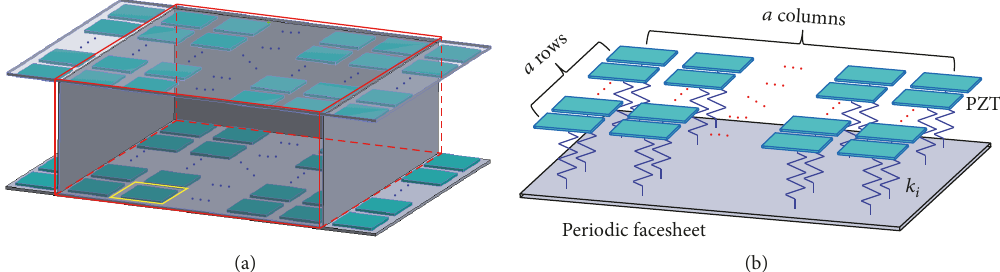
Figure 2: Local type view of basic element: (a) a periodic element (front rib-stiffener and top facesheet are transparent) and (b) flexible connections between piezoelectric patches and bottom